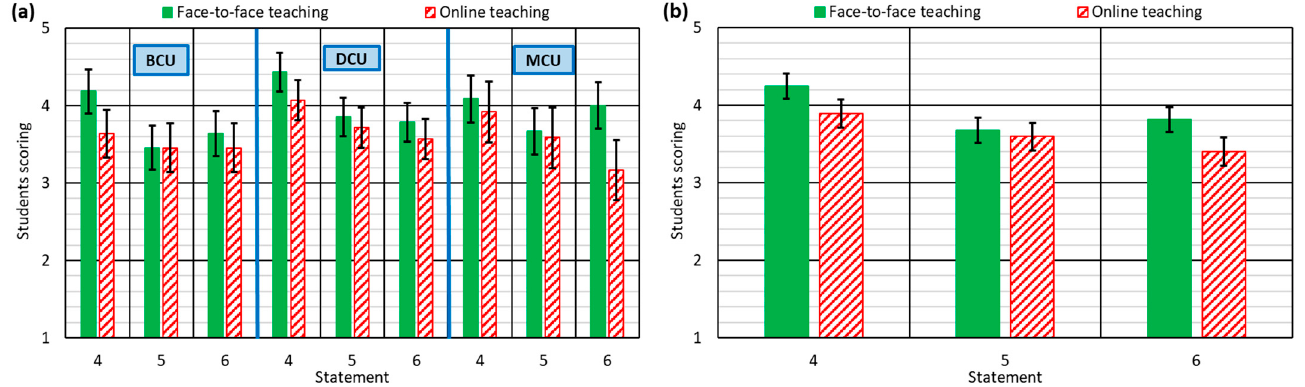
Figure 2. Student responses to statements 4–6: ( a ) for each type of course unit; ( b ) for all course units.